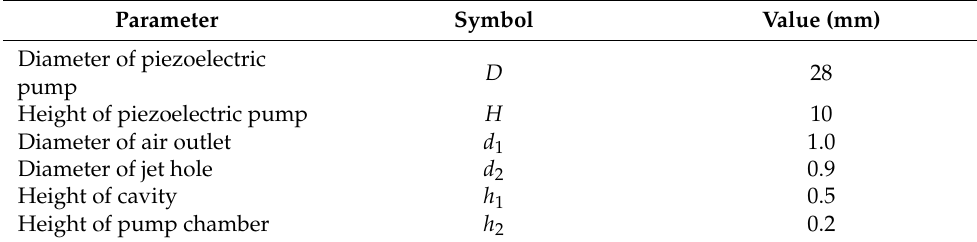
Table 2. Structural parameters of the piezoelectric air pump. Parameter